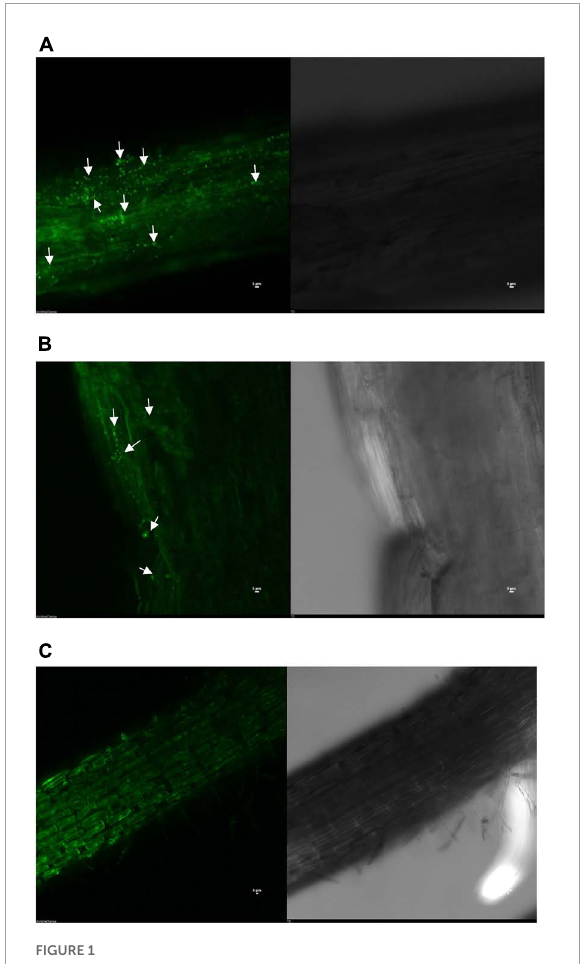
FIGURE1 Confocal microphotograph showing root colonization by S. maltophilia DRC-18-7A (A) , S. pavanii DRC-18-7B (B) and uninoculated control (C) .